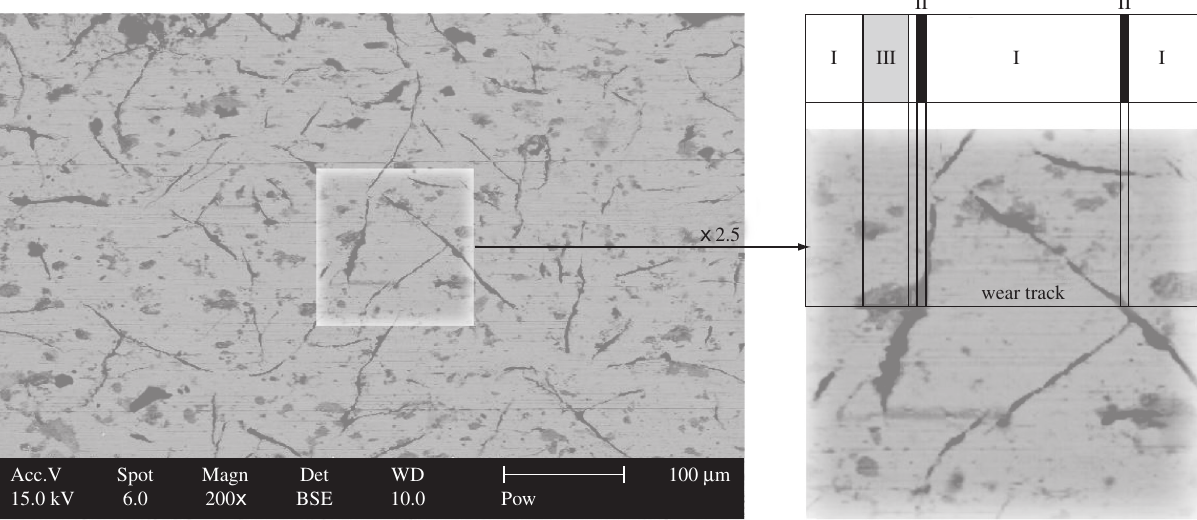
Figure 3. Zones of the wear track of the automotive grey cast iron disc: metallic structure (zone I), graphite flake (zone II), pit (zone